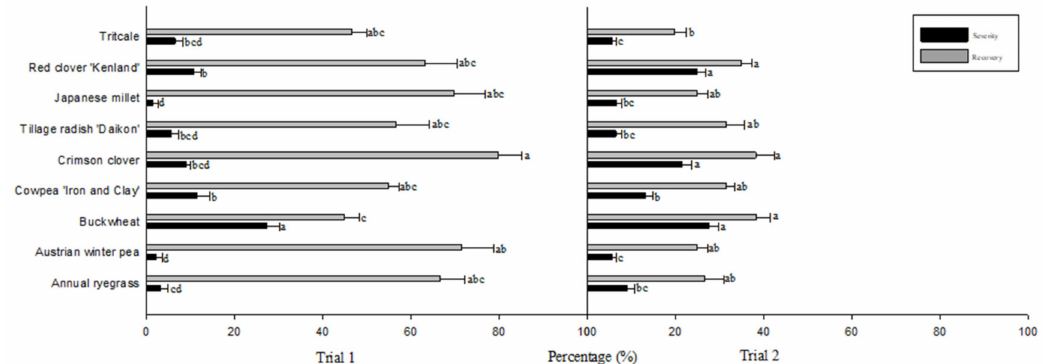
Figure 3. Disease severity and recovery (mean ± SE) of cover crops when Rhizoctonia solani was inoculated in the soil. Rhizoctonia root rot disease severity was evaluated using a scale of 0–100% of roots affected. For each replication, ten randomly selected cover crop root samples were plated on Rhizoctonia semi-selective medium to determine the percent recovery of R. solani from root samples. Different letters on the bars indicate significant differences in Rhizoctonia root rot disease severity and pathogen recovery among cover crops (Trial 1: Severity: F = 19.22, p < 0.001; Recovery: F = 4.28, p = 0.0007; Trial 2: Severity: F = 33.76, p < 0.0001; Recovery: F = 4.43, p = 0.0005; df MST,MSE = 8, 45; α = 0.05, least square